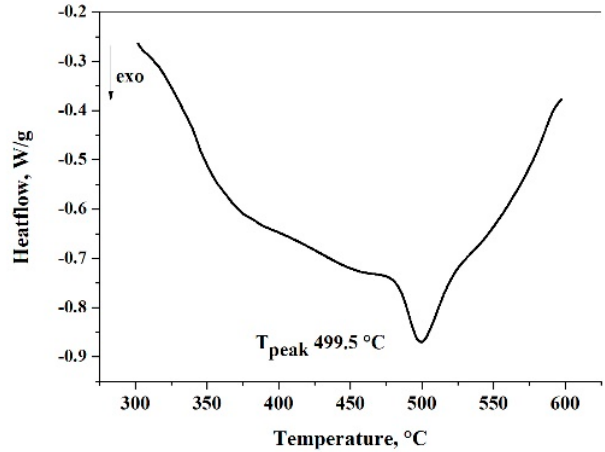
Figure 12. DSC curve from the composite powder after 30 h milling time using ethanol measured at a heating rate of 40 K/min.